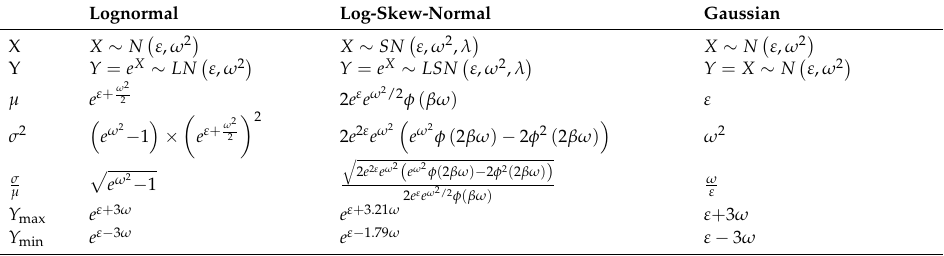
Table 1. The property of lognormal, log-skew-normal and Gaussian distributions. Lognormal